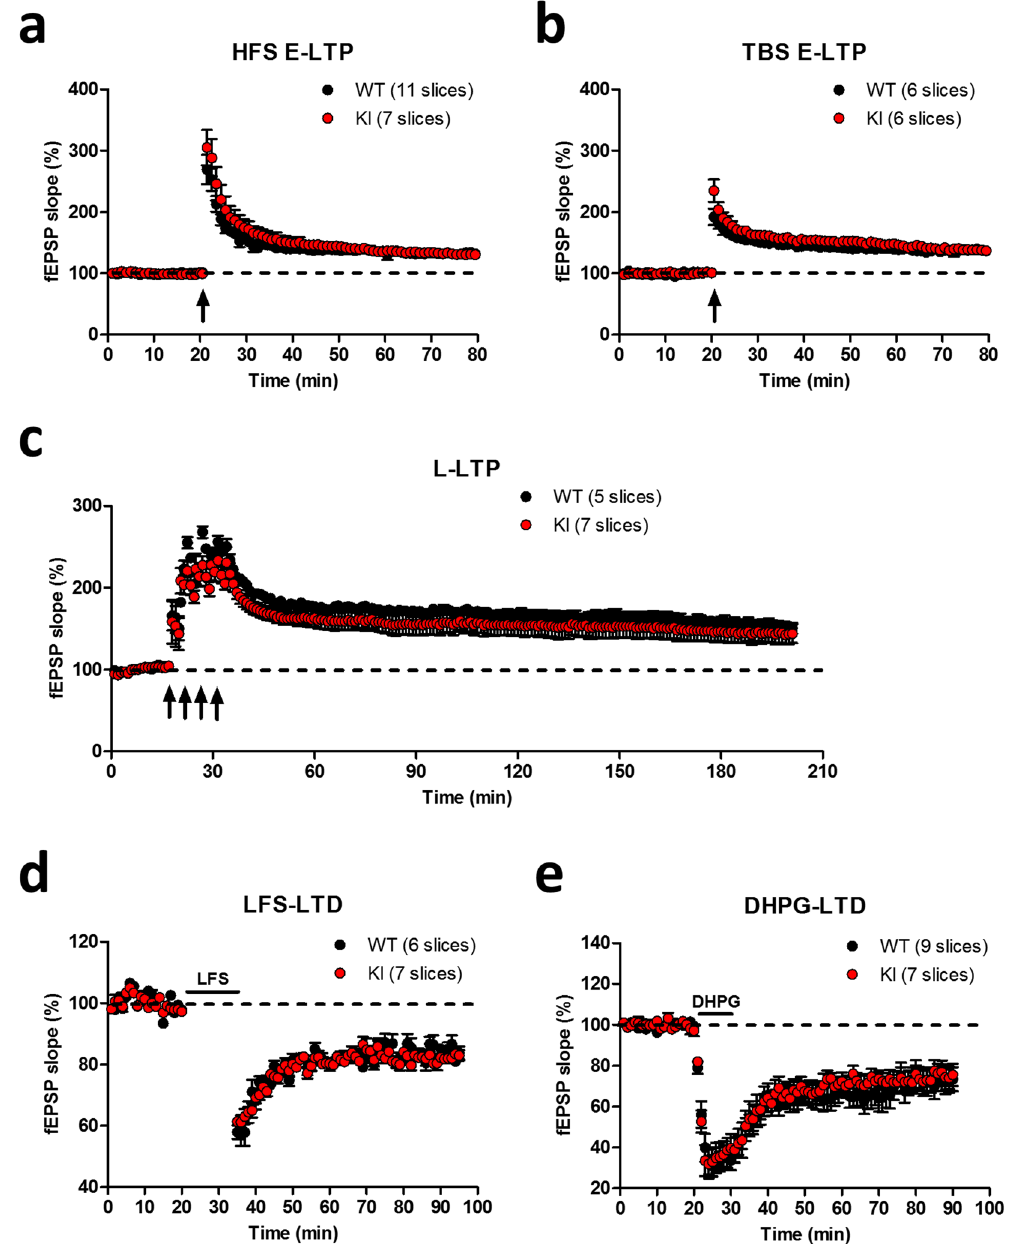
Figure 5. Long-term synaptic plasticity is not changed in Lsd1 KI mice. ( a ) High frequency stimulation (HFS)- induced early LTP (E-LTP) at SC-CA1 synapses showed no difference in WT and Lsd1 KI mice (WT: n = 11, KI: n = 7). ( b ) Theta burst stimulation (TBS)-induced E-LTP at SC-CA1 synapses showed no difference in WT and Lsd1 KI mice (WT: n = 6, KI: n = 6). ( c ) Four trains of high frequency stimulation-induced late-LTP (L-LTP) was not different between WT and Lsd1 KI mice (WT: n = 5, KI: n = 7). ( d ) NMDA-R-dependent LTD induced by low frequency stimulation (LFS) at SC-CA1 synapses in WT and Lsd1 KI mice were comparable (WT: n = 6, KI: n = 7). ( e ) DHPG-induced mGluR-LTD at SC-CA1 synapses showed no difference between WT and Lsd1 KI mice (WT: n = 9, KI: n =